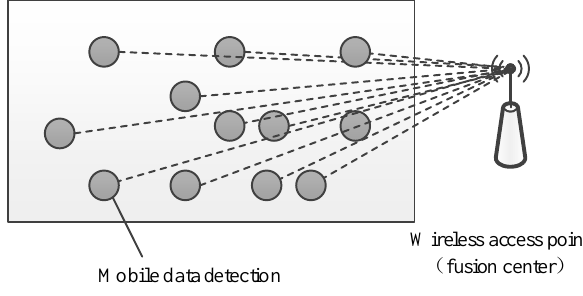
Figure 3. Single ‐ hop wireless networks. Figure 3. Single-hop wireless